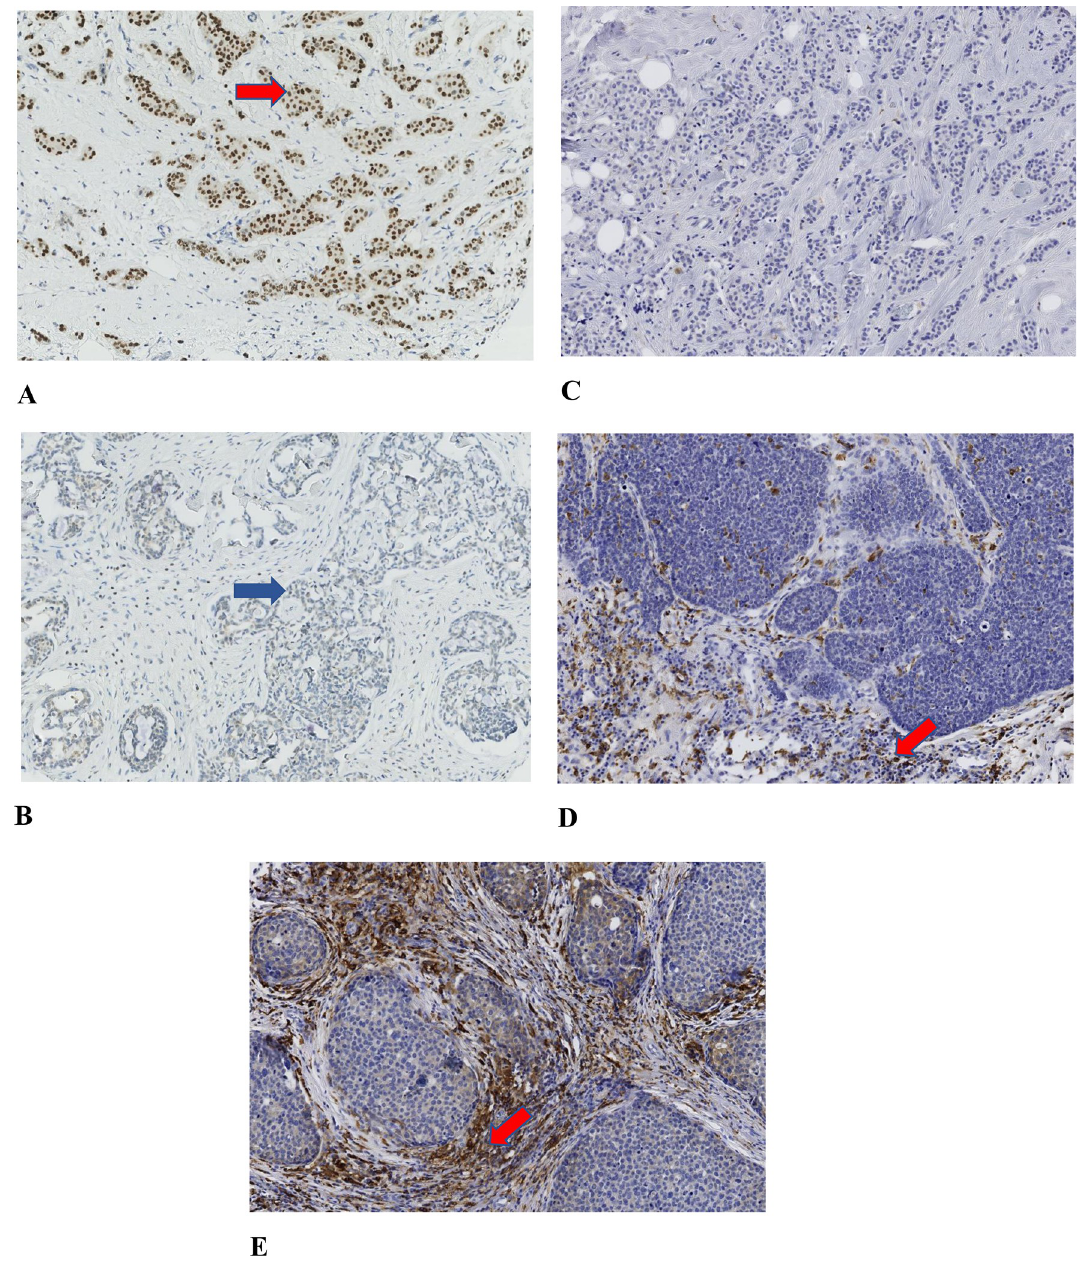
Fig 1. Breast cancer immunohistochemistry images. Image A shows a tumor with GATA-3 positive cancer cells (nuclear staining marked with a red arrow). Image B illustrates a GATA-3 negative tumor where cell nuclei (blue arrow) show no GATA-3 staining. Images C-E show immunohistochemistry for M2-macrophage specific marker CD163 used for detecting M2-macrophages (red arrow) and scoring macrophage infiltration. Images C, D, and E illustrate No/low, moderate, and high macrophage infiltration,